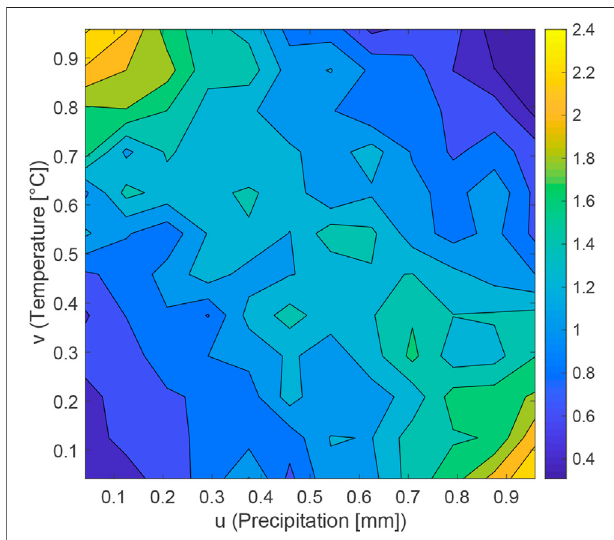
FIGURE 7 | Composite empirical copula with joint P and T pairs from all stations of GHCN-D data during the period 2006 – 2010. See Figure 1 for observation stations included in the